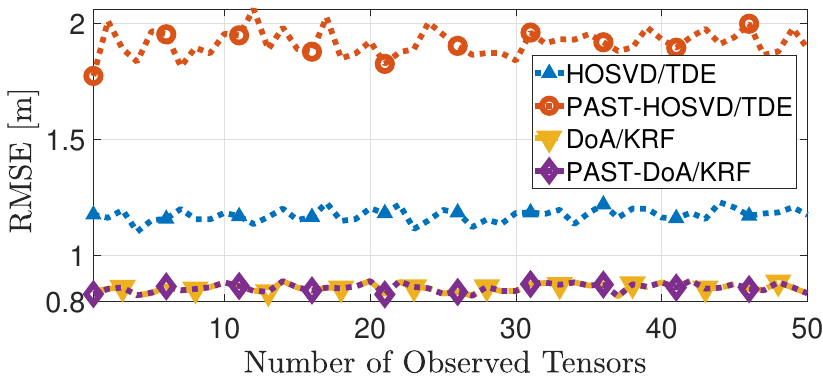
Figure 2. Comparison between the proposed techniques PAST–DoA/KRF and PAST-HOSVD/TDE and the state-of-the-art techniques DoA/KRF [11] HOSVD/TDE [10] in terms of RMSE.